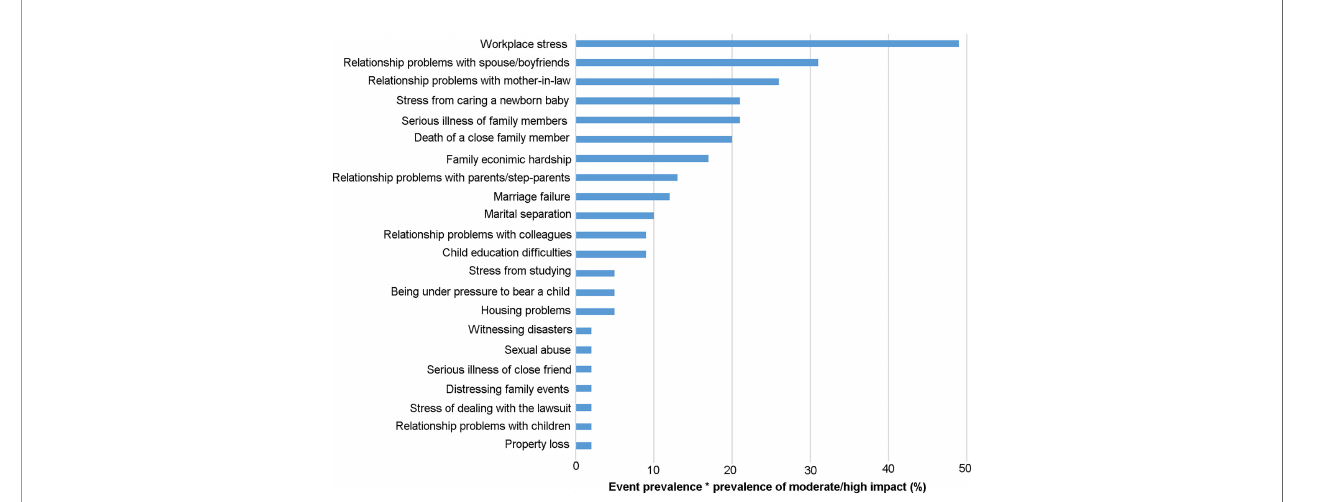
FIGURE 1 | Stressful life events with the prevalence-impact scores. The prevalence of stressful life events and the frequency of moderate/high impact is treated as percentages, and their product is multiplied by 100 to obtain the frequency-impact